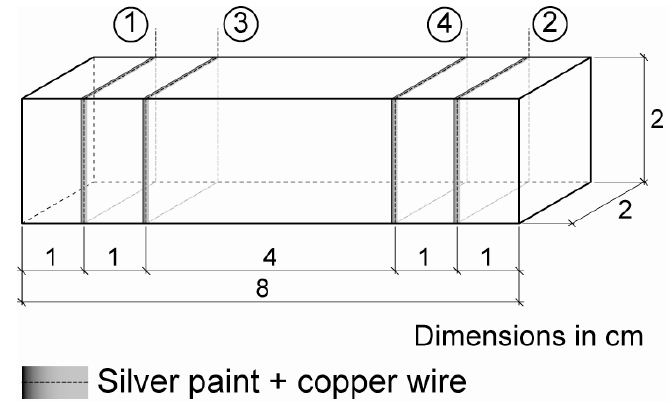
Figure 2. Electrical contacts: 1 and 2 are for current input; 3 and 4 for voltage